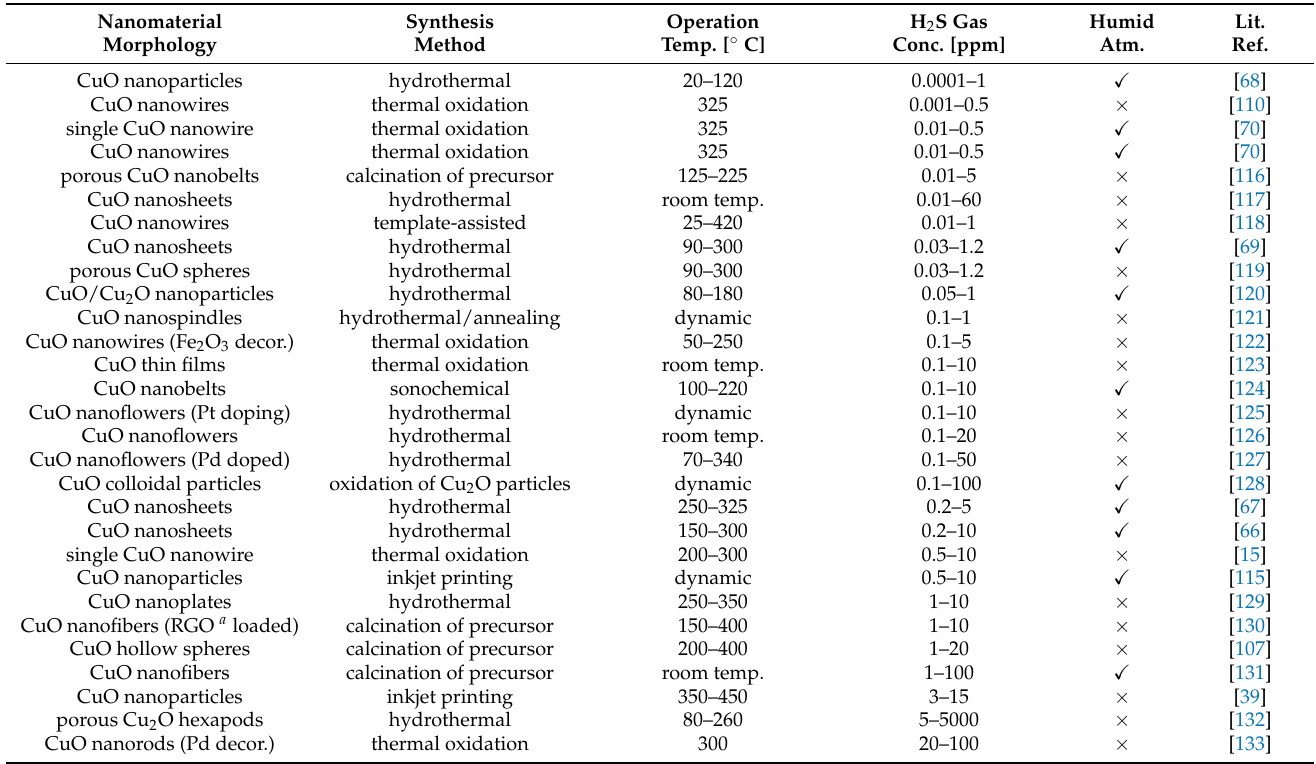
Table 2. A summary of sensing hydrogen sulfide (H 2 S) with copper oxide-based